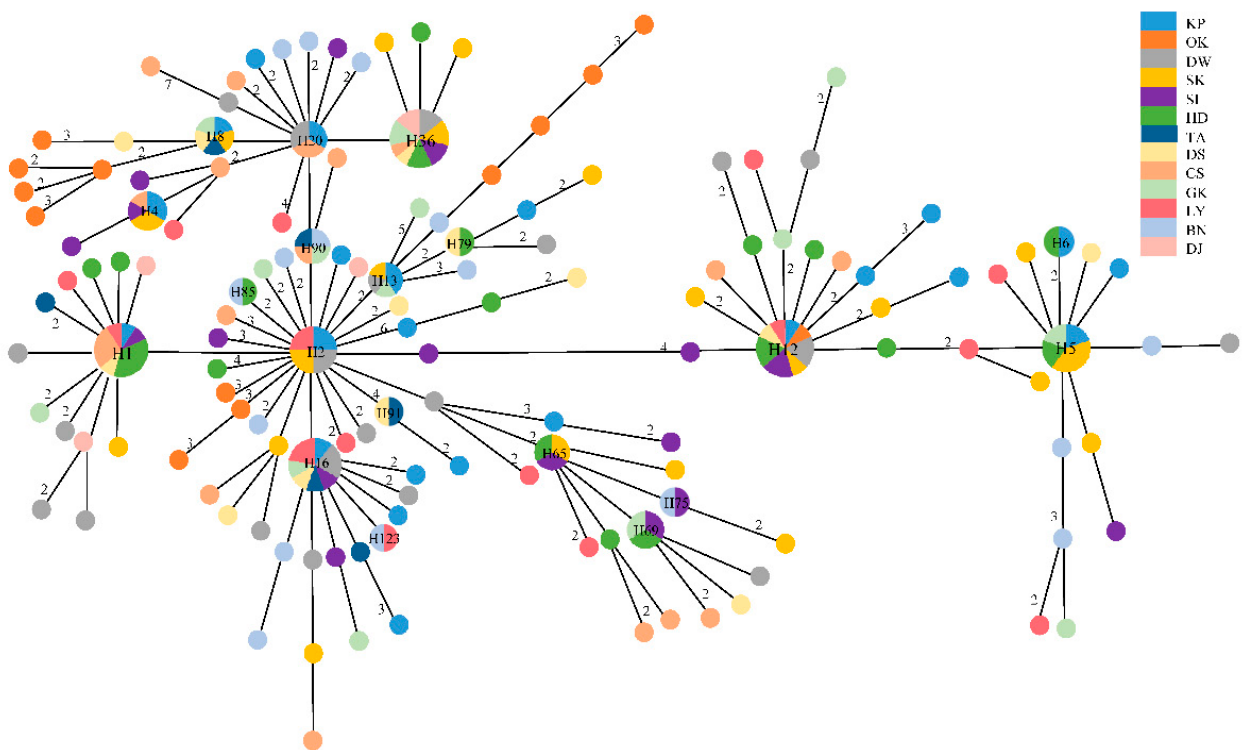
Figure 3. The median-joining network of 142 haplotypes of Macrobrachium japonicum based on partial mtDNA COI gene. Each circle represents a haplotype, and the circle size is proportional to the haplotype frequency. Black numbers in the bars across the branches are the number of mutational steps. Table 2. Analysis of molecular variance (AMOVA) for Macrobrachium japonicum populations in three scenarios based on partial mtDNA COI gene.